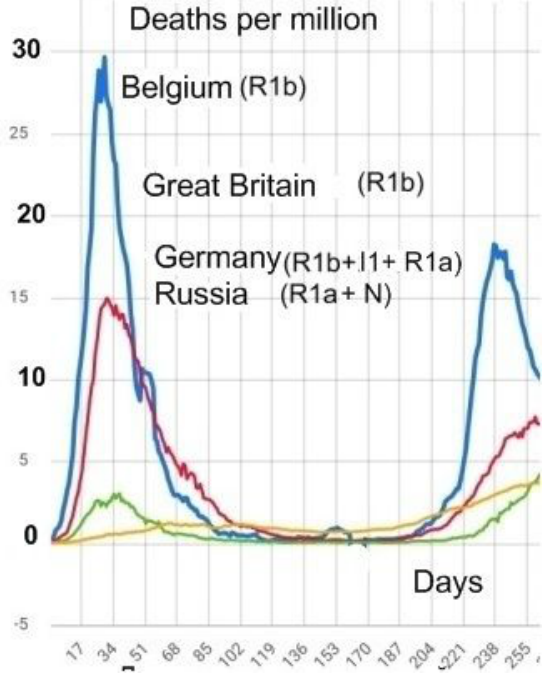
Figure 4. The development of the COVID-19 pandemic in various countries before the start of mass vaccination, per 1 million (based on the Johns Hopkins University data): the relative number of deaths in countries with haplogroups R1b and R1a. Blue line – Bel- gium, purple – UK, green – Germany, yellow – the European part of